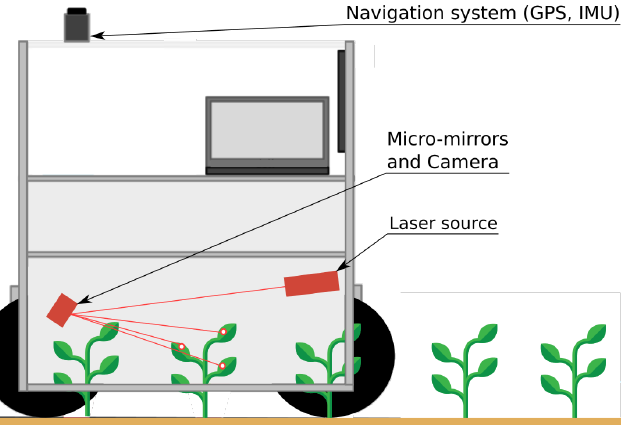
Figure 2. Greenshield prototype description and working principle: the robot spans a crop row, detects the aphids on leaves, and targets them using the laser beam positioned by the